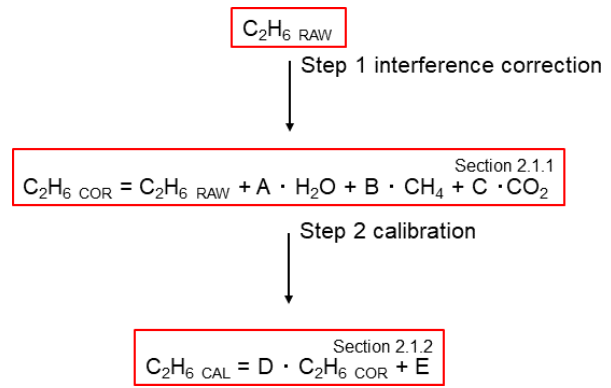
Figure 1. Flowchart of steps to use C 2 H 6 measured by CRDS G2201-i. The number in the corner corresponds to the subsection where methods of each step are